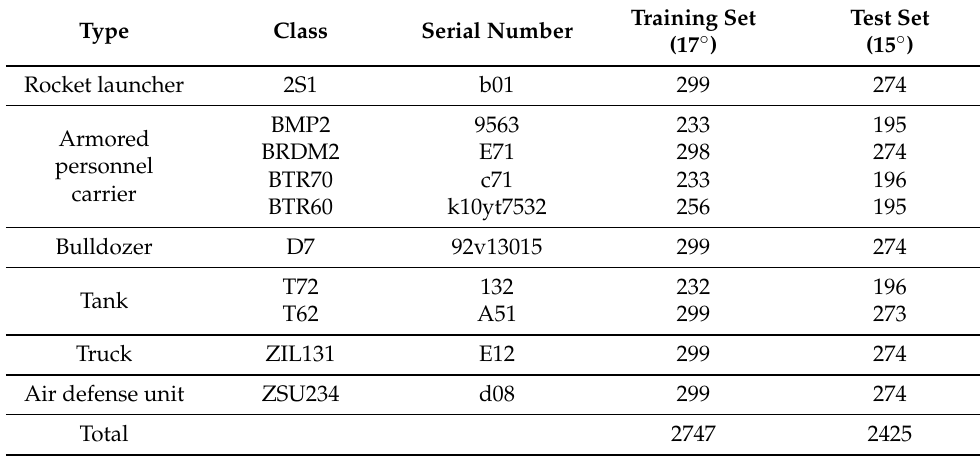
Figure 2. Examples of the targets in the MSTAR dataset: ( top ) optical images; and ( bottom ) the corresponding SAR images. Table 1. Details of the SOC subset of MSTAR